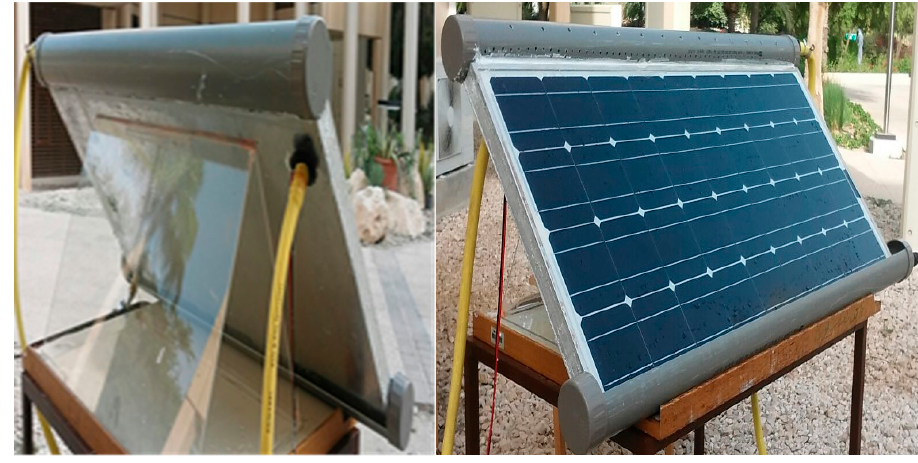
Figure 2. Backside surface and active (front) surface cooling design of PV.